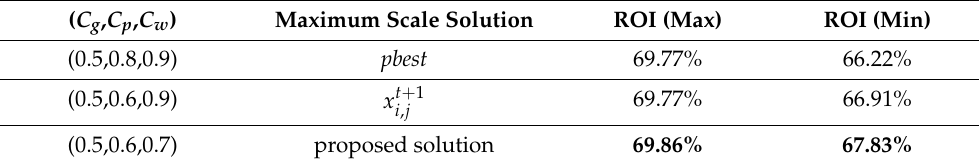
Table 7. Best and worst solutions under different parameter combinations (Experiment 2).